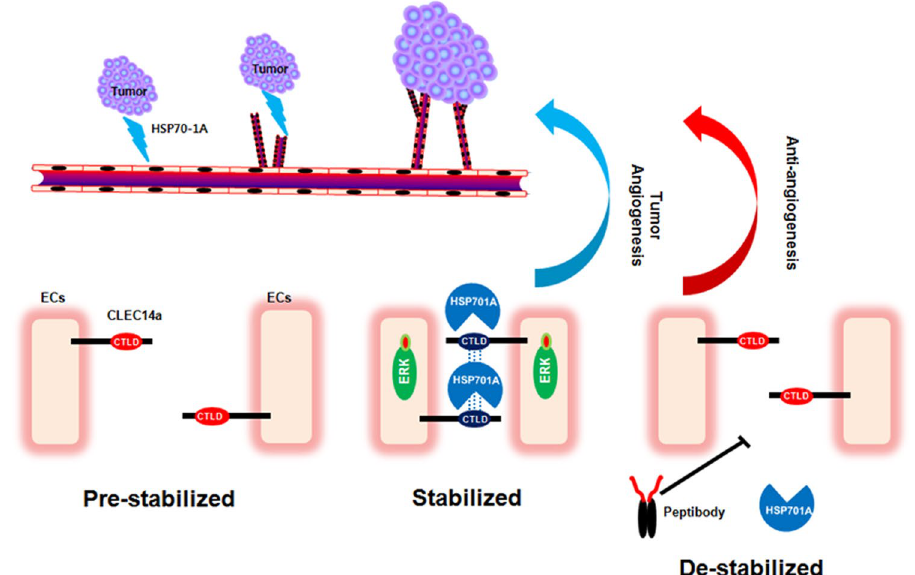
Figure 7. Schematic showing the role of the CLEC14a-CTLD-HSP70-1A interaction in HSP70-1A-induced angiogenesis, and the effect of a peptibody inhibitor of this interaction. When extracellular HSP70-1A secreted from tumor cells specifically binds to the CLEC14a-CTLD of CLEC14a expressed on endothelial cells under pre-stabilized conditions, HSP70-1A stabilizes the conformation of CLEC14a-CTLD and facilitates the CLEC14a-CLEC14a interaction that mediates endothelial cell-cell contact. These interactions stimulate ERK phosphorylation and endothelial tube formation, which are critical for HS70-1A-induced angiogenesis. The application of a peptibody that can specifically block the CLEC14a-CTLD-HSP70-1A interaction will destabilize endothelial cell-cell contacts to inhibit HSP70-1A-induced